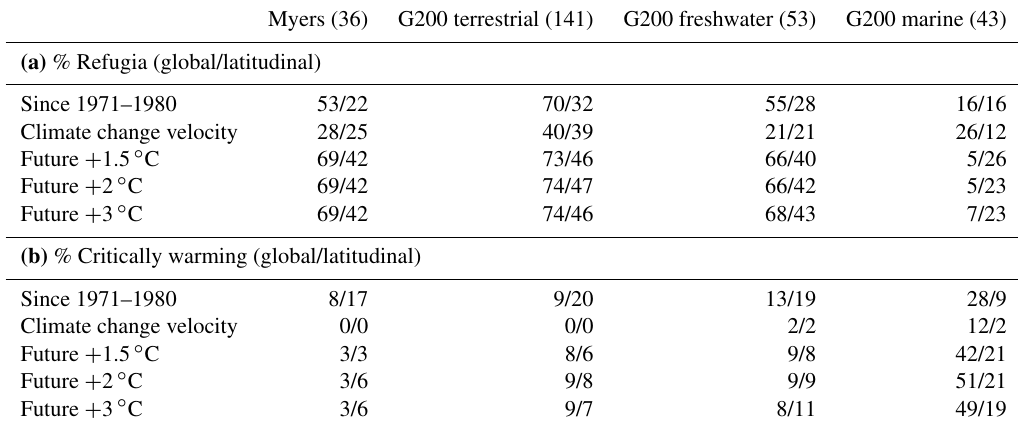
Table 1. The percentage of rich spots in each environment that have (a) the global and latitudinal mean above 97.5% of the values within them (global/latitudinal refugia) and (b) those that have the mean below percentile 2.5 (globally/latitudinally warming). The number of rich spots considered is shown in parentheses. The Lord Howe and Norfolk Island rich spot of the terrestrial G200 is not included in the assessment due to its small